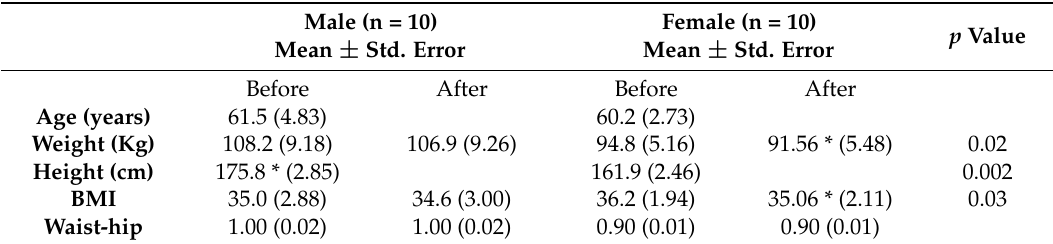
Table 1. Anthropometric measurements of participants before and after the intervention.